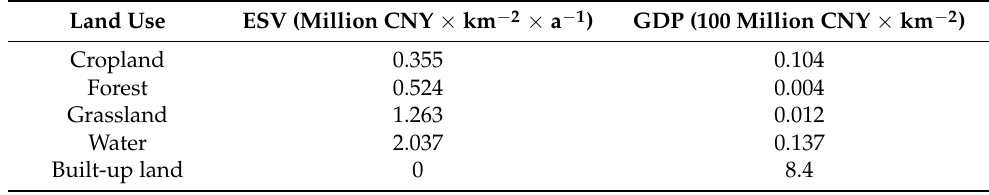
Table 3. The unit ESV and GDP in each land use